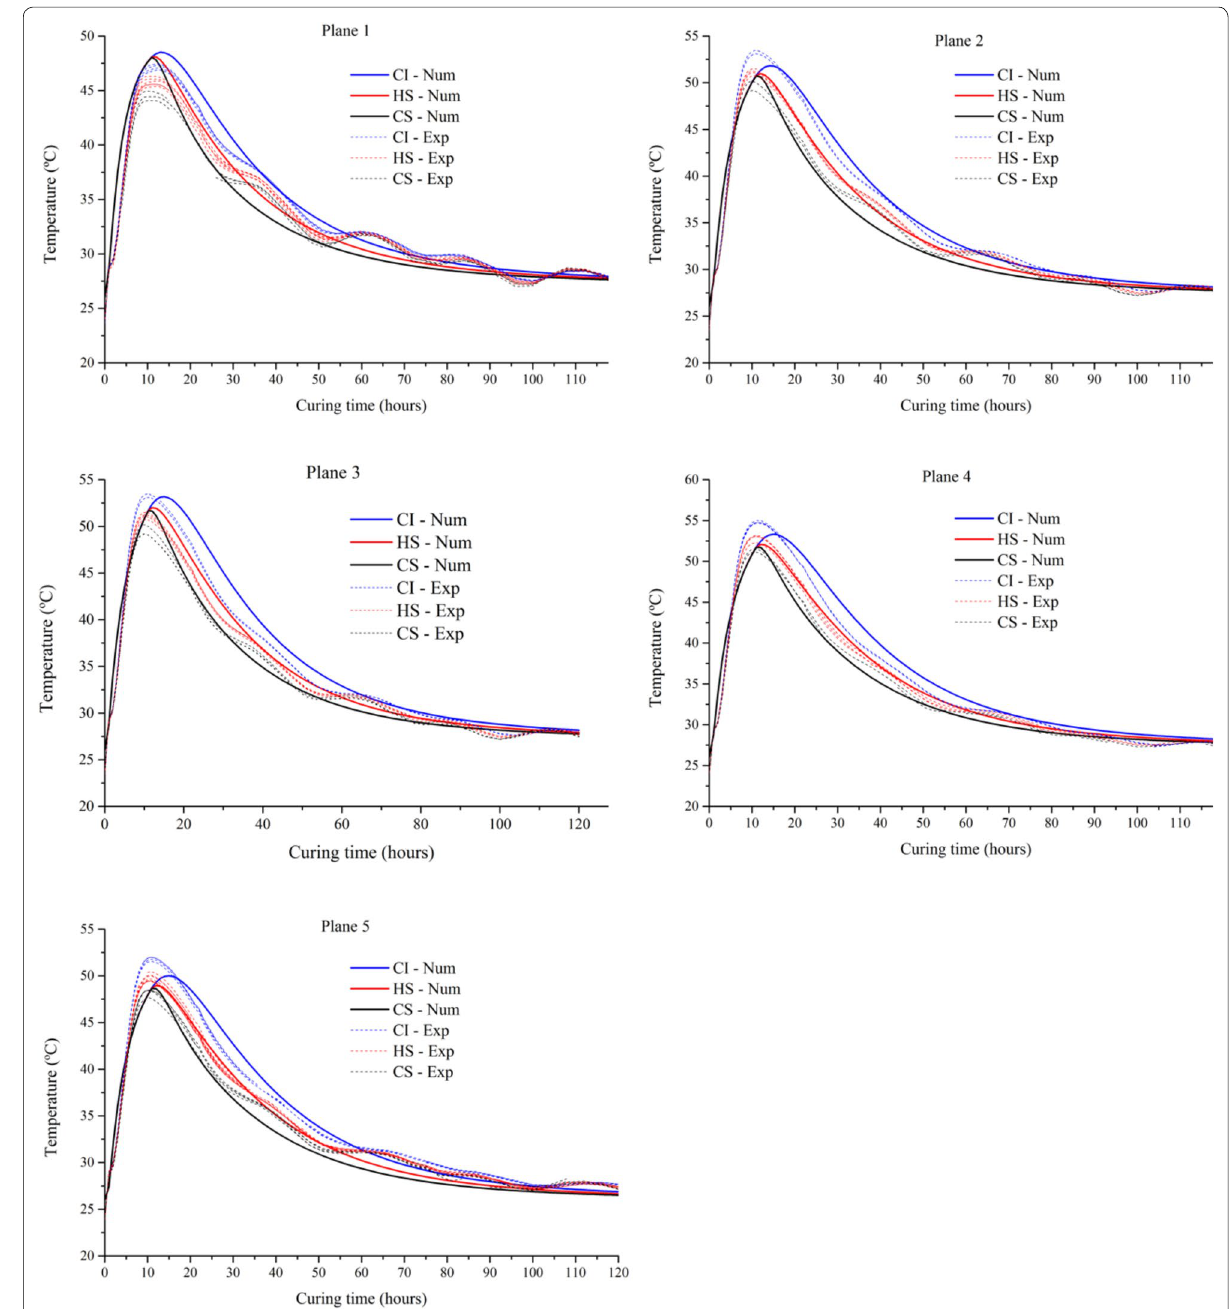
Fig. 10 Comparison of the numerical results for the temperature evolution of the concrete with respect to the experimental results for different sensors at five different